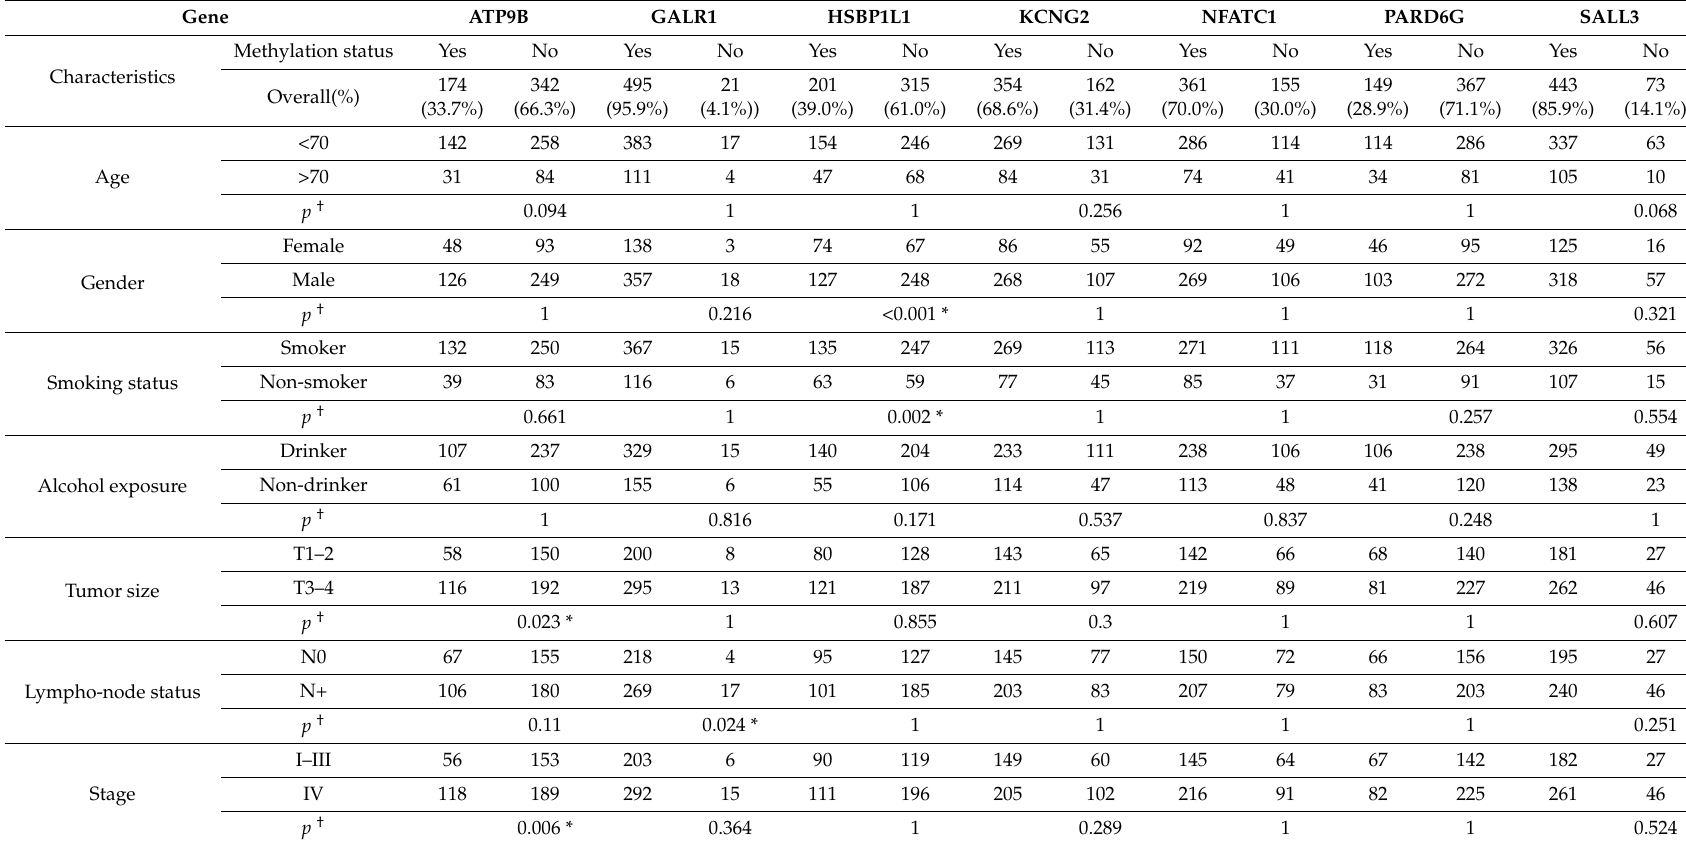
Table 2. Distribution of methylation status by selected epidemiologic and clinical characteristics in the TCGA